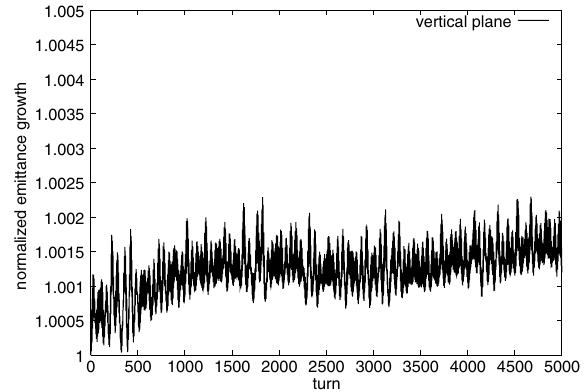
FIG. 5. The vertical normalized emittance growth of the weak beam with an initial 20% mismatch of the strong beam and 0.002 higher machine tune of the weak beam.